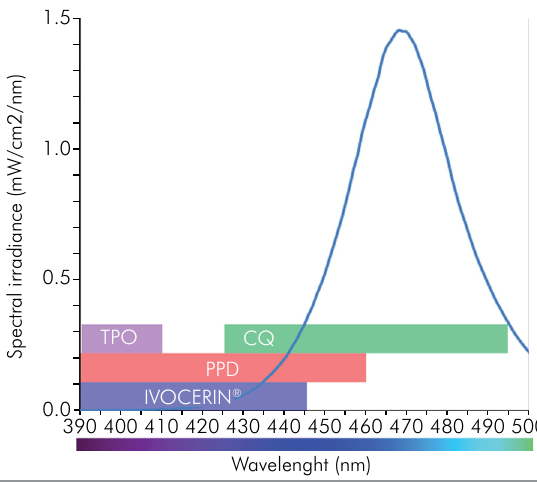
Figure 25. Spectral emission profile of an early, 1 st generation blue LED dental curing light.